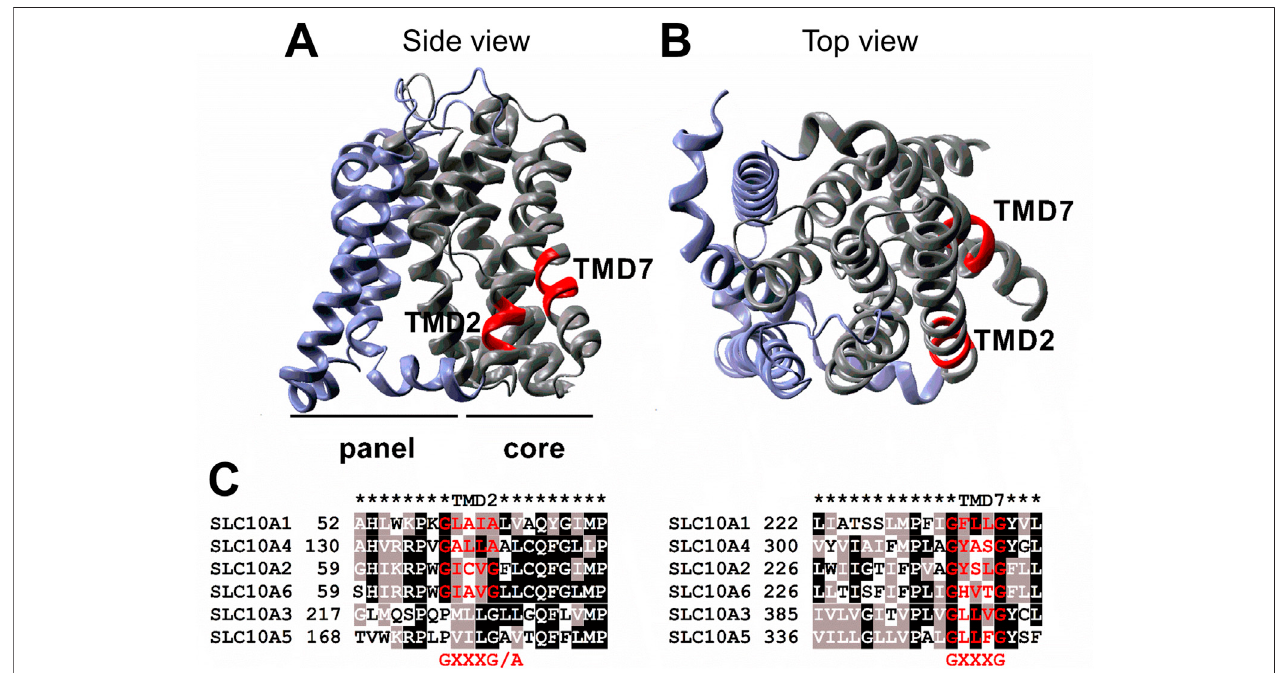
FIGURE 5 | Location of the GXXXG/A motifs in TMD2 and TMD7 of NTCP. An NTCP homology model ( A: side view; B: top view) was generated based on the crystalstructureofabacterialhomologbySWISS-MODELasoutlinedundermaterialsandmethods.Thepaneldomainisdepictedinblueandthecoredomainisshown in grey. The GXXXG/A motifs in TMD2 and TMD7 are highlighted in red. (C) Sequence alignment of the protein sequences of the Solute Carrier Family 10 members A1- A6, with NTCP representing SLC10A1. Sequence alignment was performed with the EBI Clustal Omega alignment tool (www.ebi.ac.uk) using the protein sequences with the following GenBank Accession Numbers: SLC10A1/NTCP: NP_003040, SLC10A2/ASBT: NP_000443, SLC10A3: NP_062822, SLC10A4: NP_ 689892, SLC10A5: NP_001010893, and SLC10A6/SOAT: NP_932069. The alignment was visualized by BoxShade (https://embnet.vital-it.ch/software/BOX_form.